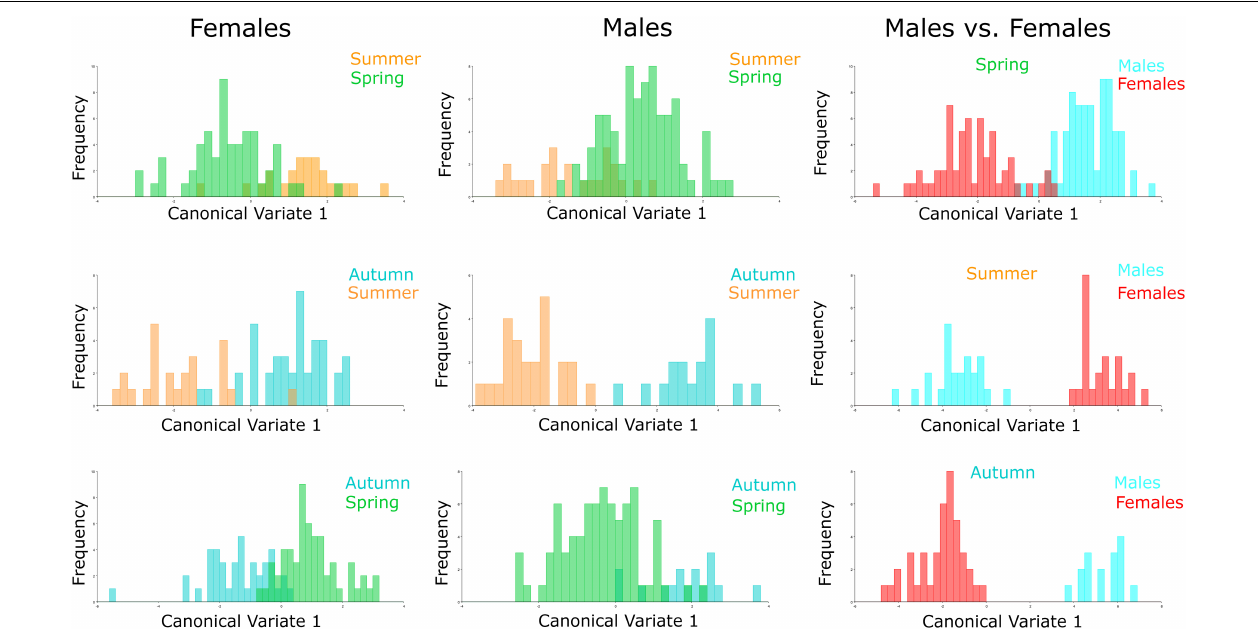
FIGURE 4 | Comparison of specimens by season. Morphological space produced by CVA of Ae. albopictus males, females and males vs. females collected in autumn 2017 (red), spring 2018 (green), and summer 2018 (blue). Females: Summer-Spring ( P = 0.2275), Autumn-Summer ( P = 0.0269), Autumn-Spring ( P = 0.0002); Males: Summer-Spring ( P = 0.1151), Autumn-Summer ( P = 0.2900), Autumn-Spring ( P = 0.1542); Males vs. Females: Spring ( P < 0.001), Summer ( P = 0.0006), Autumn ( P < 0.001).